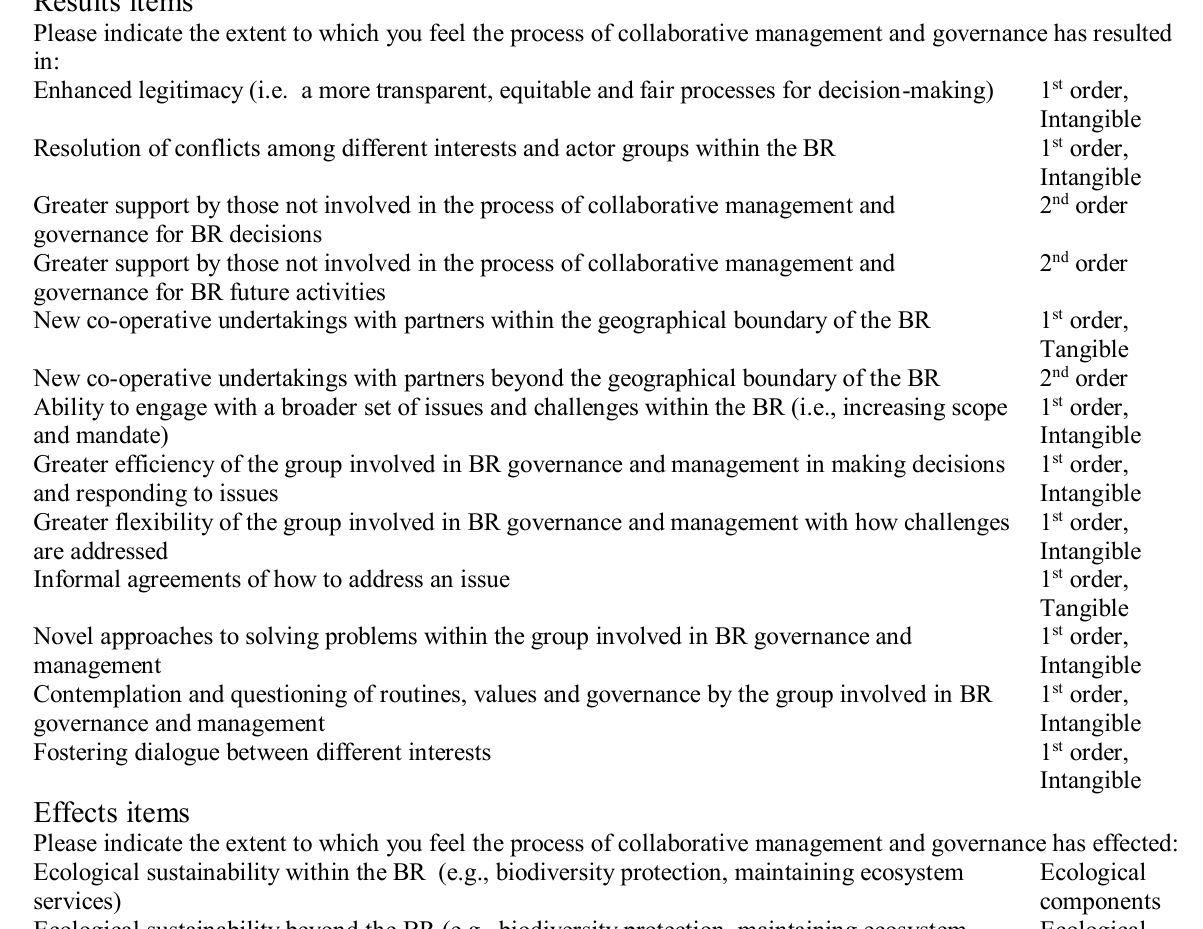
Table A4.2 Item Associated third-tier variable Results